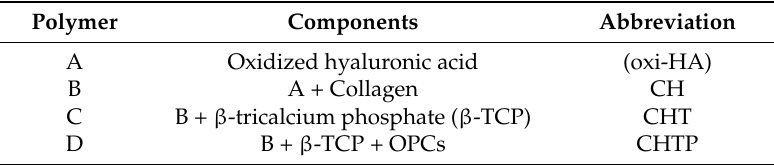
Table 1. Polymeric composites made in this